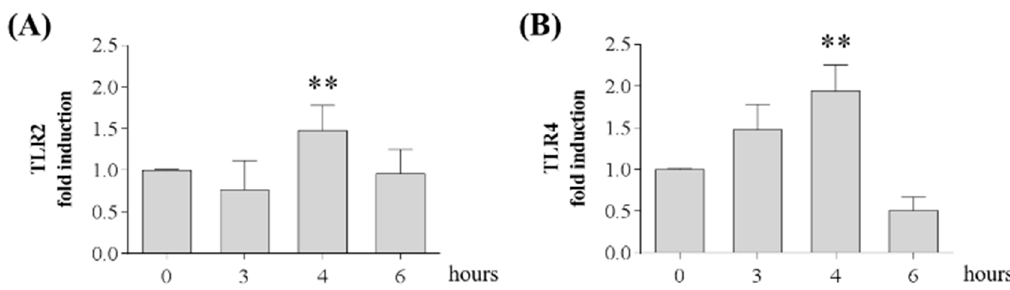
Figure 1. Oxy-mix induces TLR2 and TLR4 gene expression. TLR2 (panel A ) and TLR4 (panel B ) gene expression were evaluated through real-time RT-PCR in di ff erentiated CaCo-2 cells treated with 60 µ M Oxy-mix for 0, 3, 4 or 6 h. The significant maximum expression of both TLRs was reached after 4 h Oxy-mix cell treatment. Data are reported as means ± SD of three experiments performed in triplicate. One-way analysis of variance (ANOVA) associated with Bonferroni’s multiple comparison post-test was adopted: significantly di ff erent vs. 0 h: ** p < 0.01.